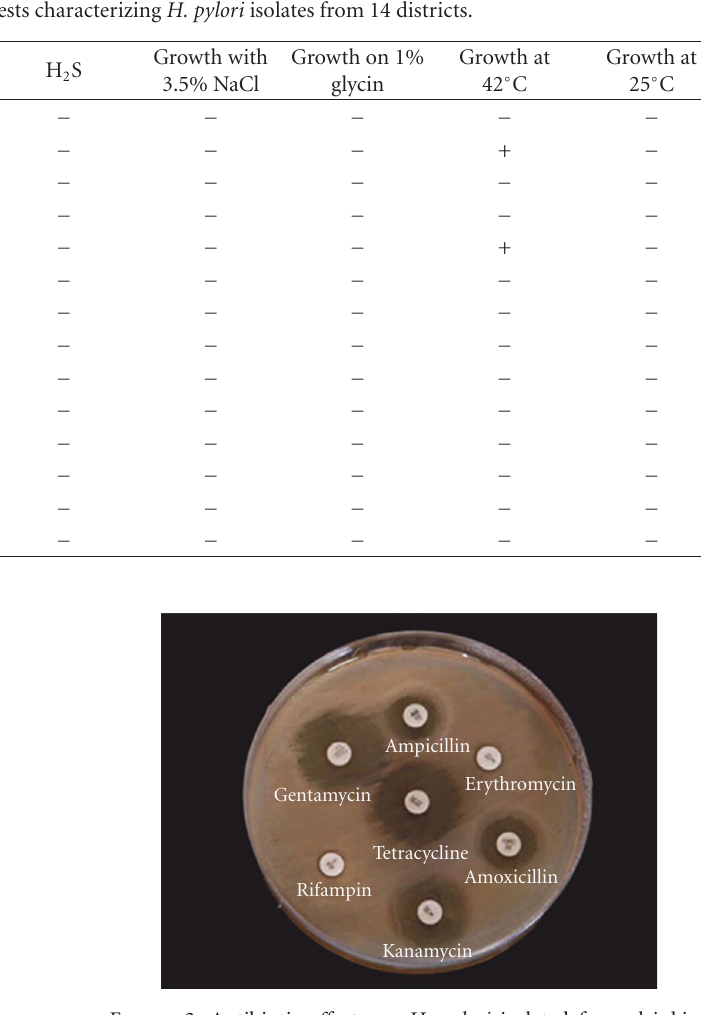
Figure 2: Antibiotic e ff ects on H. pylori isolated from drinking